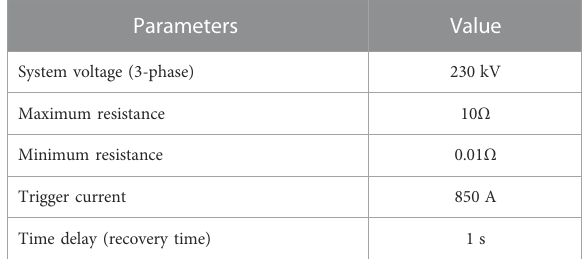
TABLE 1 Parameters used in the